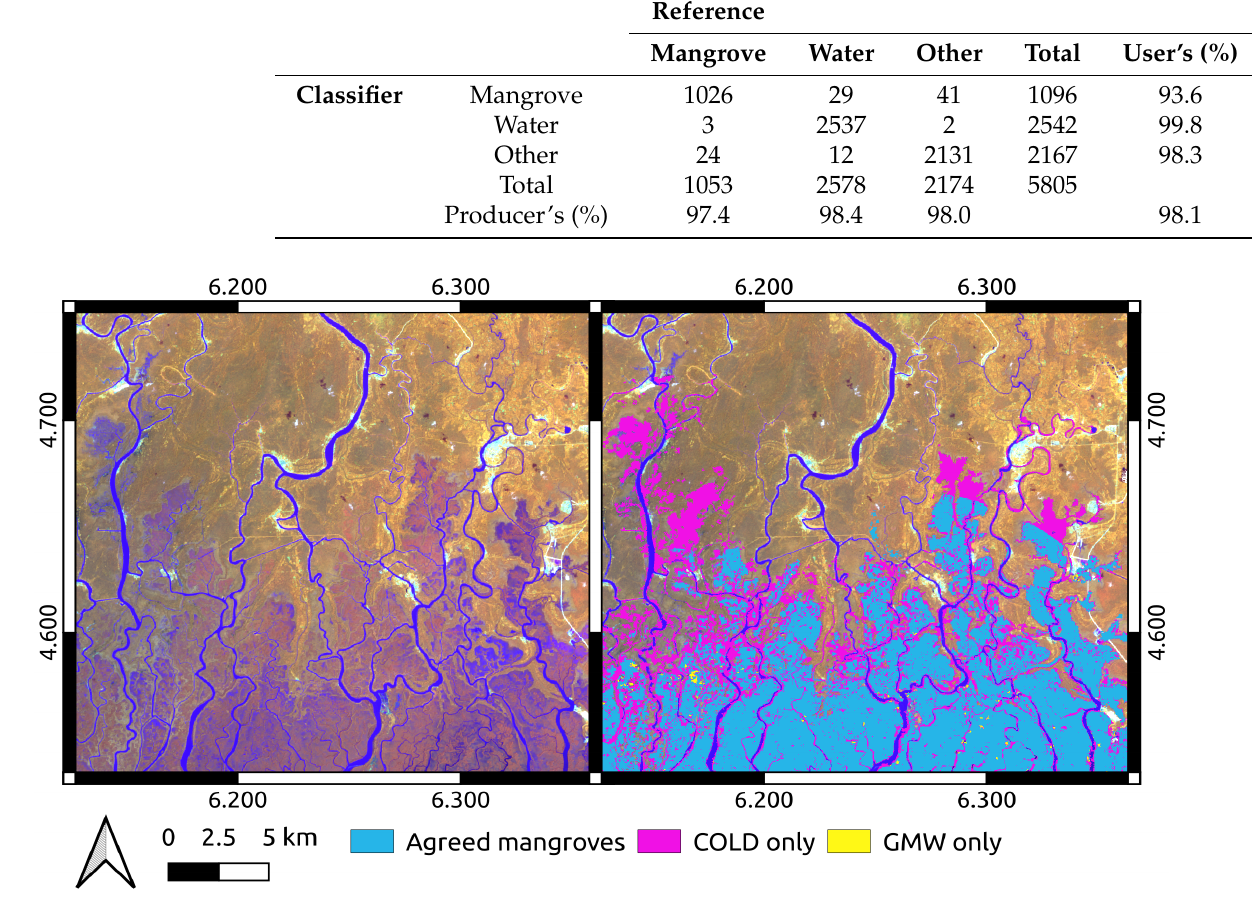
Figure 4. Example classification of mangroves in the Niger Delta. Left: false colour Landsat 8 image from December 2013 where Red = NIR, Green = SWIR1, and Blue = Red. Mangroves are clearly visible as having a purple hue which is distinct from the surrounding land cover. Right: classification of mangroves showing areas identified as mangroves by the Continuous Monitoring of Land Disturbance (COLD) algorithm which were missed by the